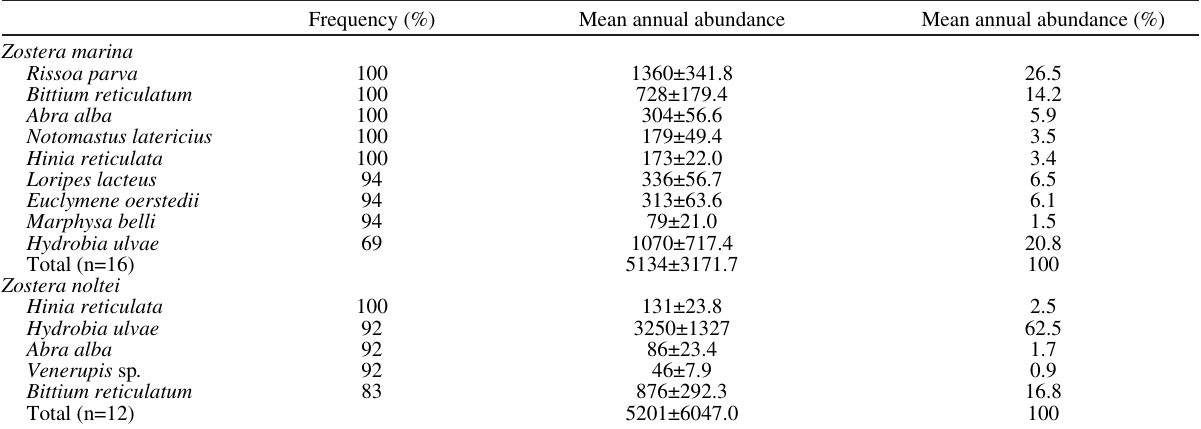
Table 3. – Frequency of occurrence (%) and mean annual abundance (ind. m –2 ± standard deviation and percentage) of the most abundant taxa (>60% of frequency) found at sampling sites in Zostera marina and Zostera noltei